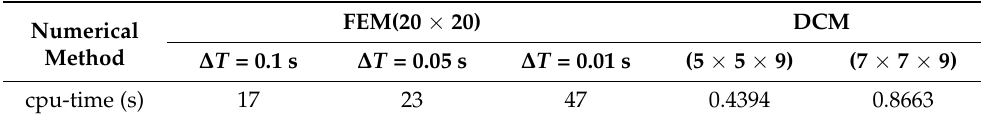
Table 5. Calculating time of FEM and